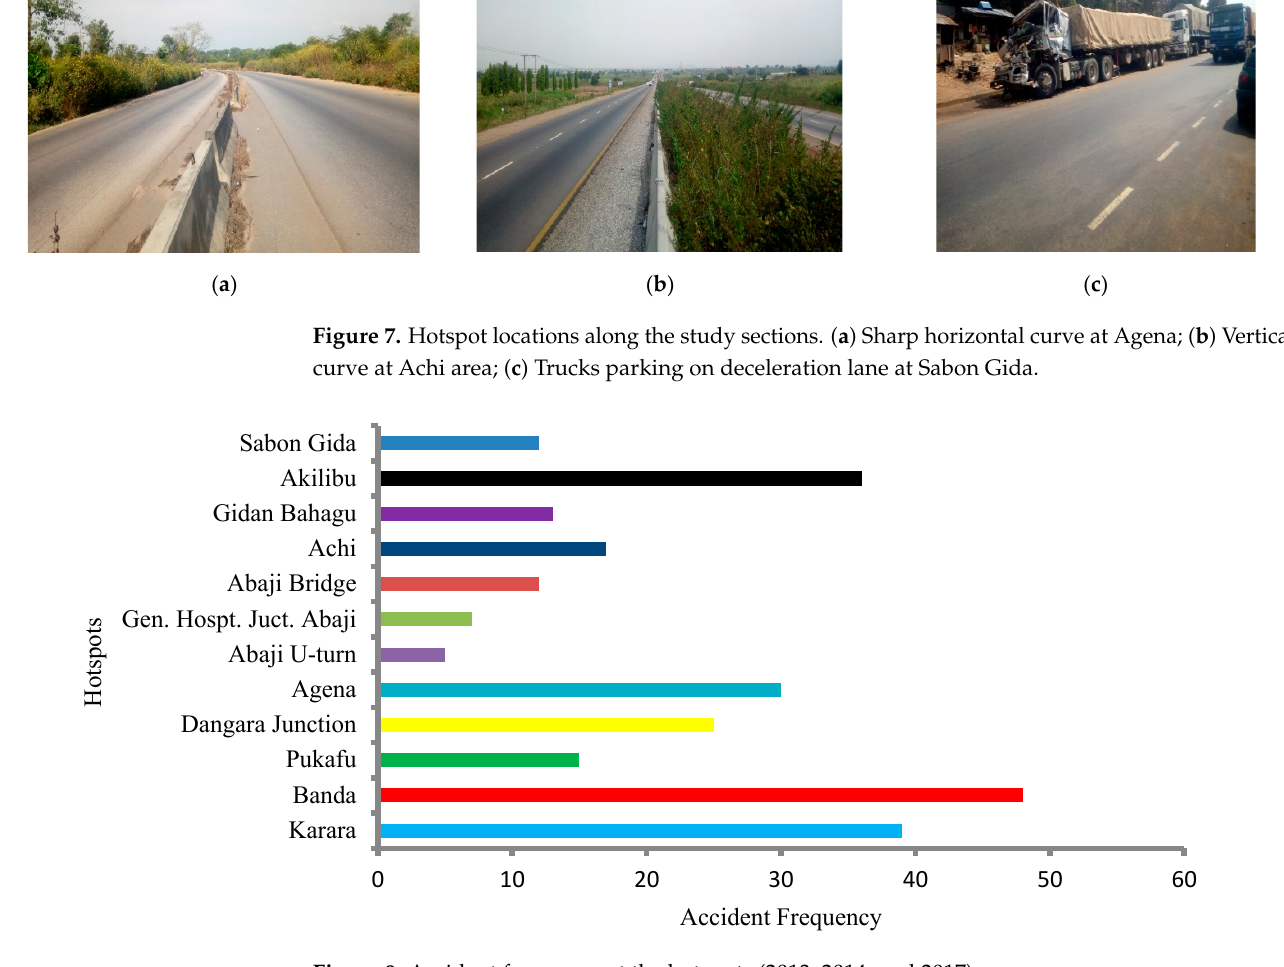
Figure 8. Accident frequency at the hotspots (2013, 2014, and 2017).